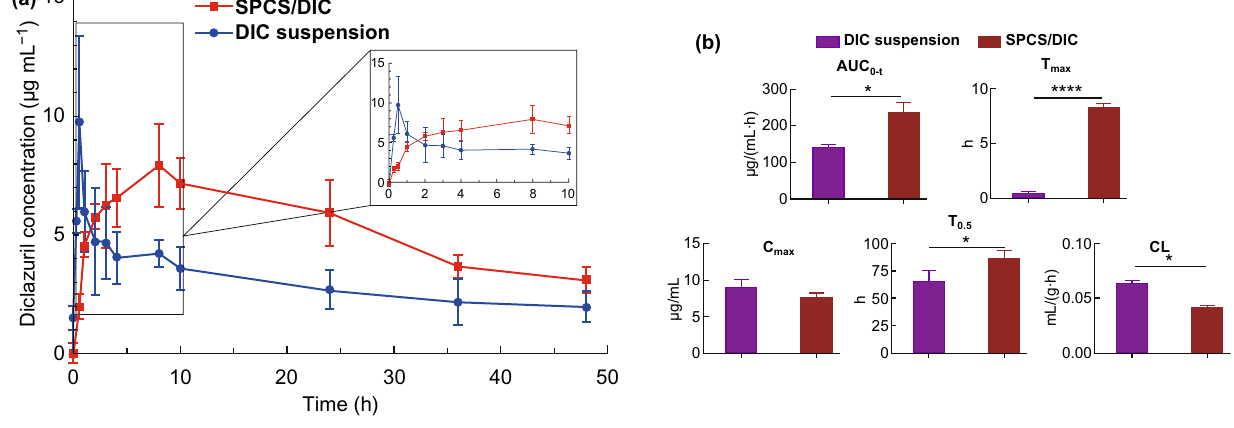
Figure 7 a Mean DIC plasma concentration (μg mL −1 ) following a single dose oral administration (15 mg kg −1 ) of SPCS/DIC micelle and DIC suspension. b Pharmacokinetics parameters following a single oral administration (15 mg kg −1 of DIC) of DIC suspension and SPCS/DIC micelles. Data represent the mean ± SD, n = 6. * p < 0.05 and **** p < 0.0001 as compared to DIC